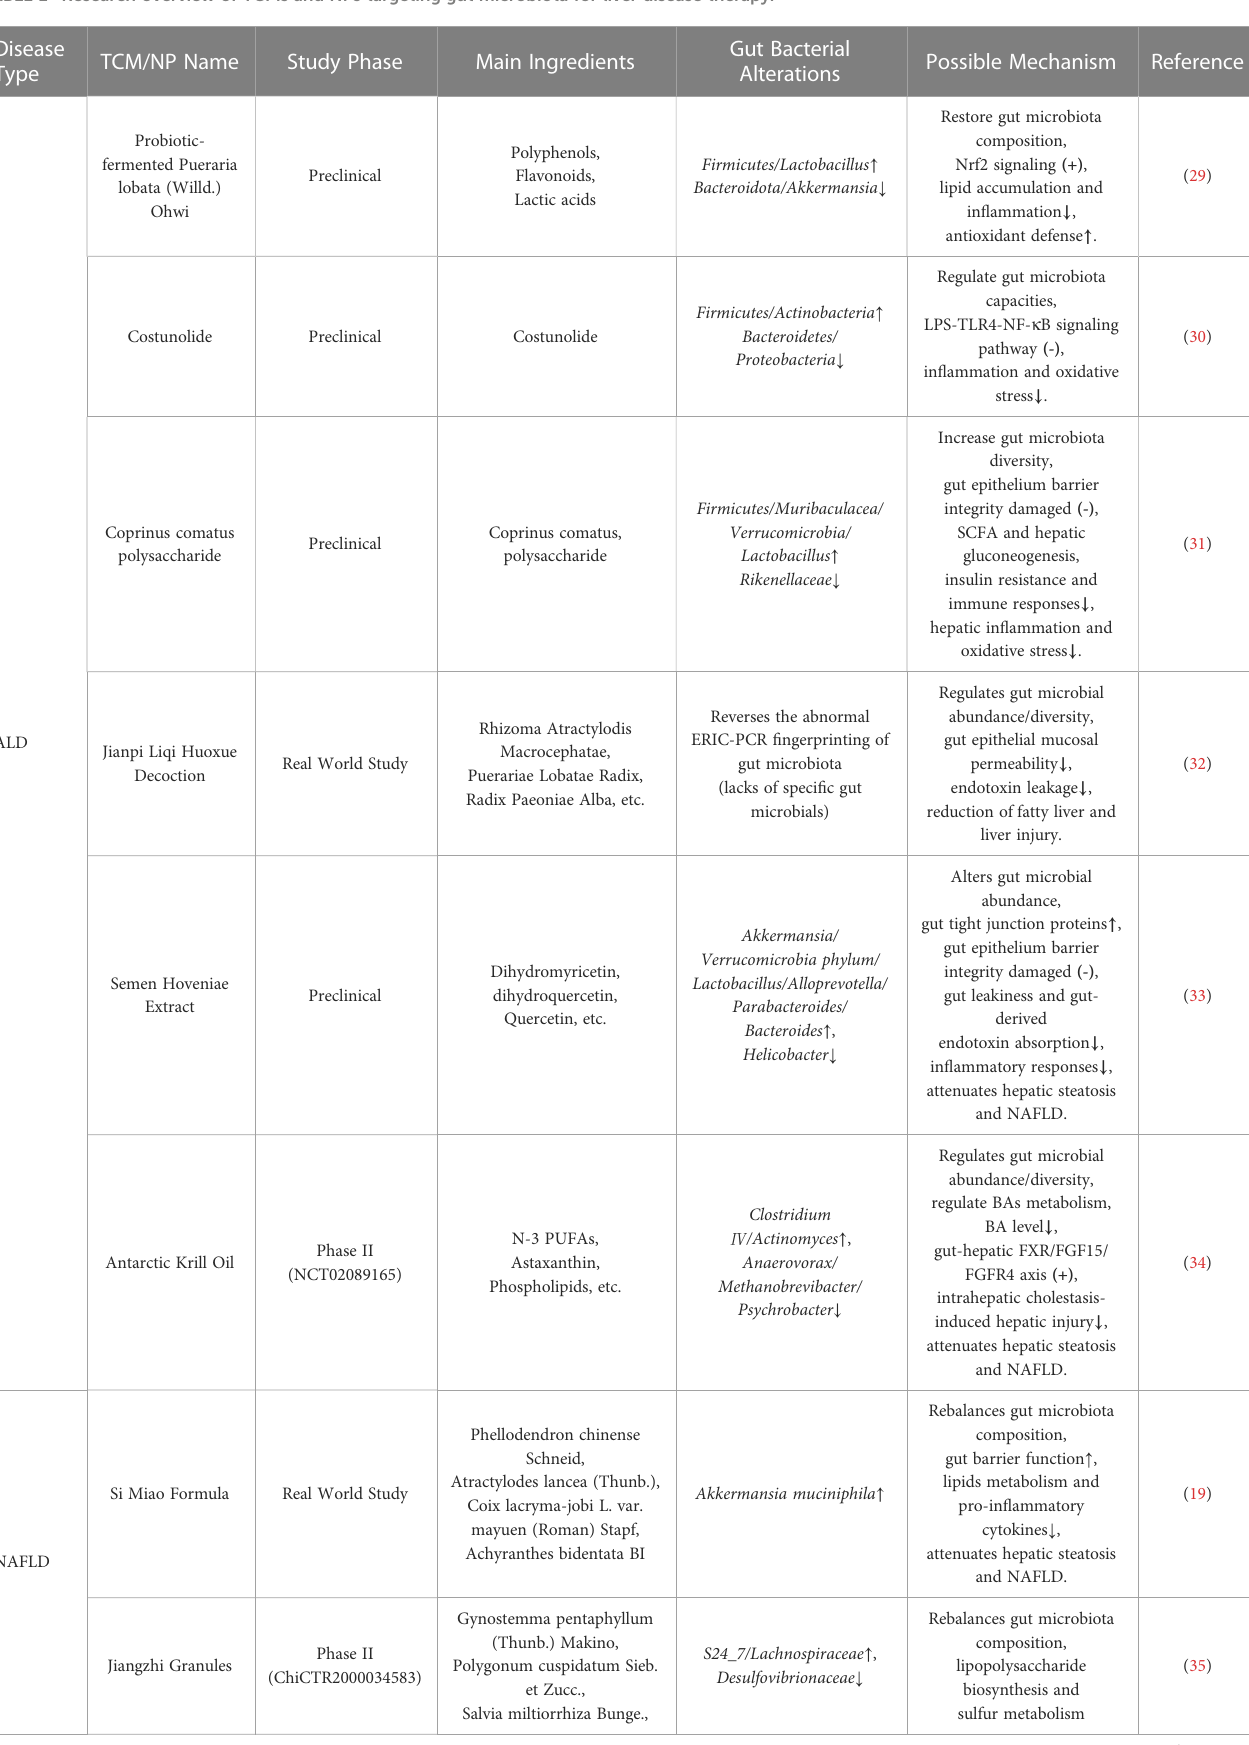
TABLE 1 Research overview of TCMs and NPs targeting gut microbiota for liver disease therapy. Disease